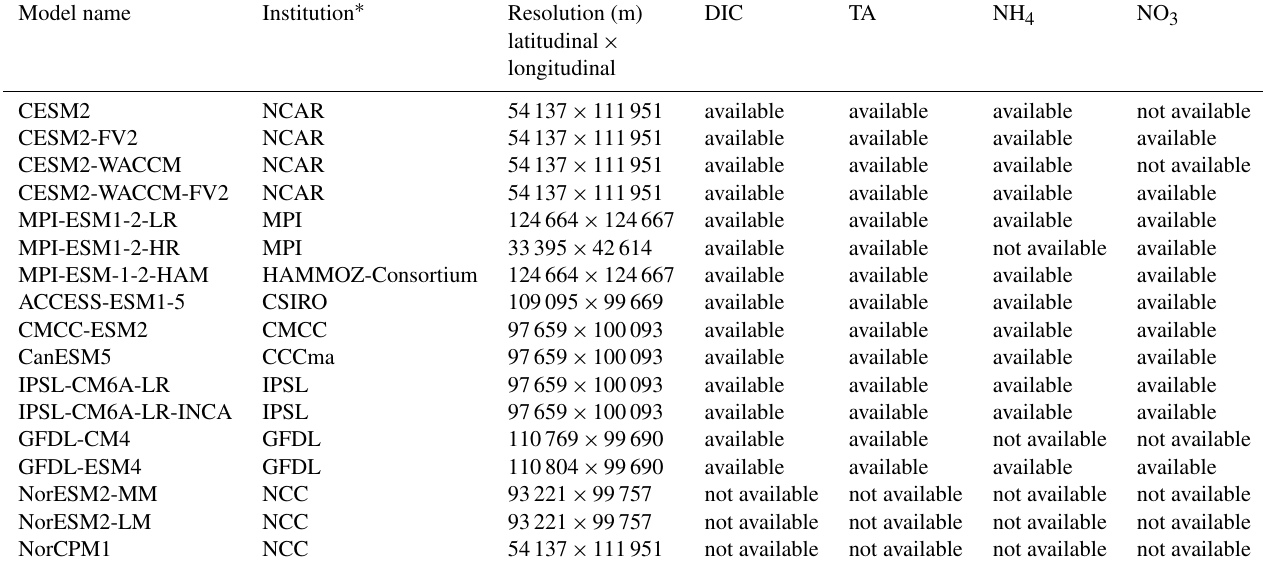
Table A1. Summary of CMIP6 GCMs considered for boundaries conditions of the regional model.